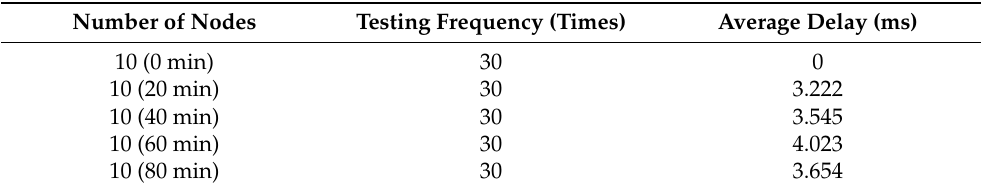
Table 5. Signal delay detection.